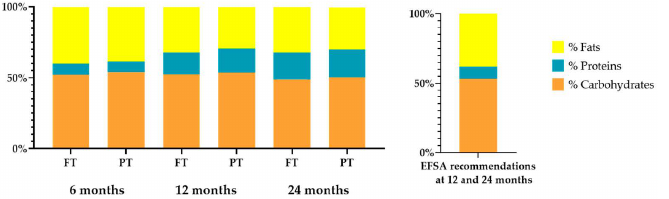
Figure 4. Percentage of the total energy intake provided by each macronutrient between full-term (FT) and preterm (PT)